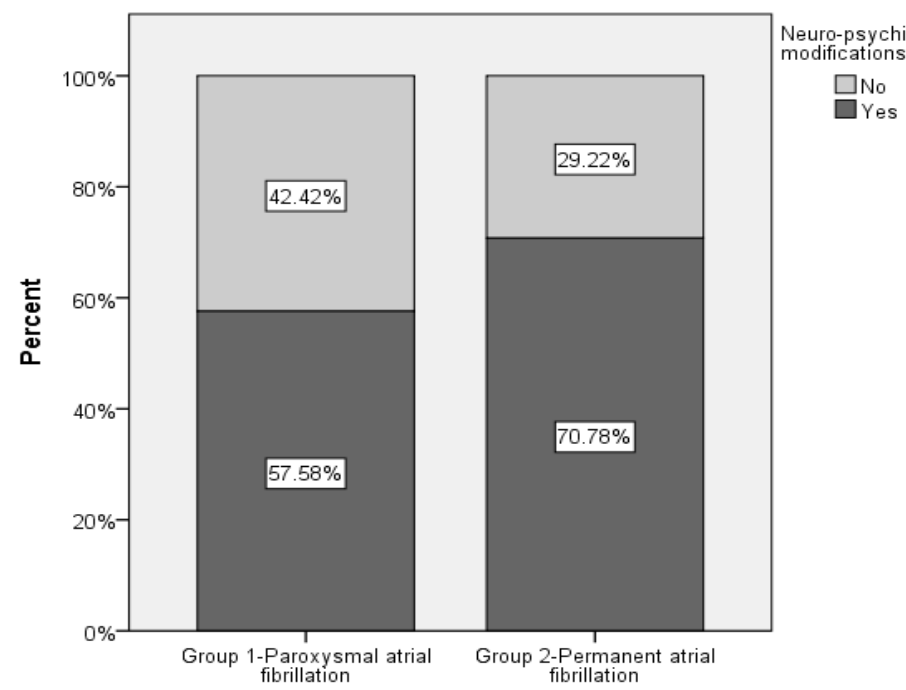
Figure 1. Bar plot with the percentage of patients with neuro-psychiatric changes by AF types. A significant statistical difference was noted for stroke (48.75% vs. 26.74%, p < 0.001) and dementia (10.25% vs. 3.86%, p < 0.001) among the two groups. Data regarding stroke, dementia, and Parkinson’s disease are presented in Table